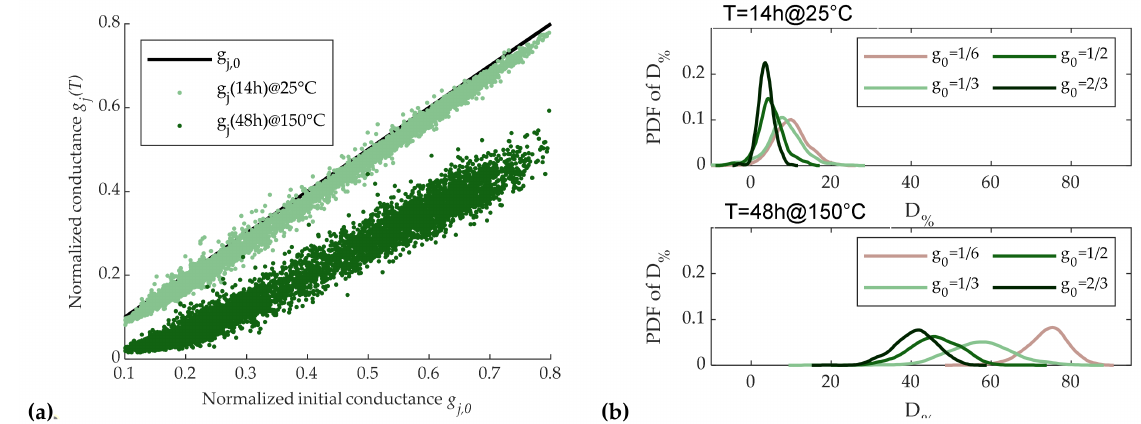
Figure 15. Effects of SSC sequence as in Figure 14 with the addition of an initial 5A S0 SET pulse and A R = 5A R0 . ( a ) Cells conductance as a function of the initial normalized conductance after 14 hours at room temperature, and after 48 hours at 150 ◦ C. ( b ) Probability distribution of D % obtained with the SSC programming sequence. Different curves refer to different target conductances with ± 10%